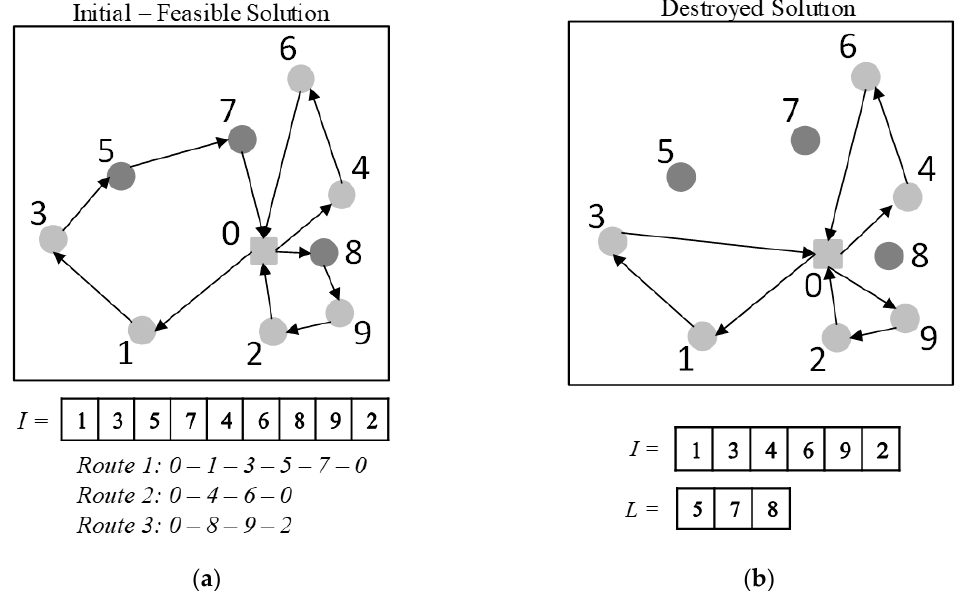
Figure 2. Removal operator. ( a ) Initial Solution; ( b ) “Destroyed” Solution.